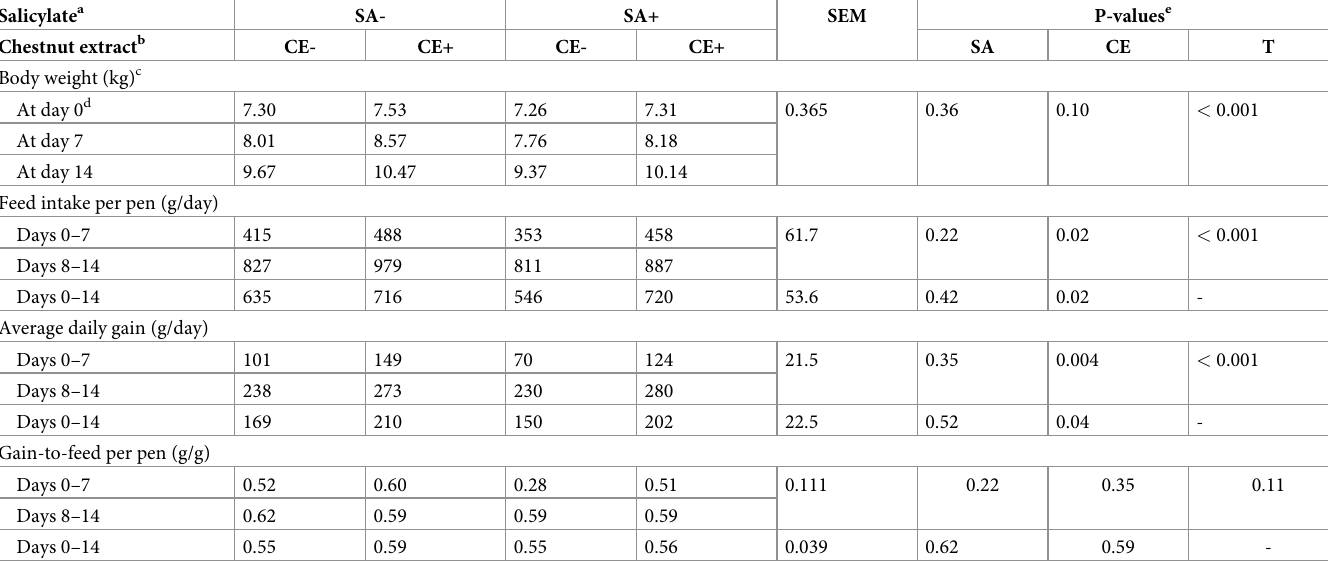
Table 2. Feed intake (g/day per pen), BW (Kg), average daily gain (g/day) and feed efficiency (g/g per pen) from days 0–7, 8–14, and 0–14 post-infection of piglets. Salicylate